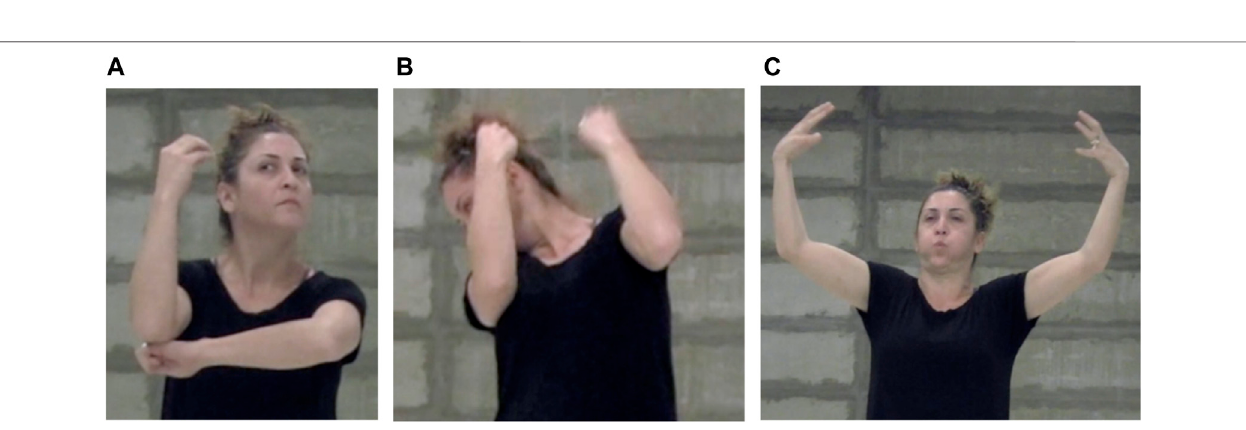
FIGURE 12 | (A) The sign LEARN with affective facial expression; (B) manipulation of the sign with a head gesture, meaning, “ learning more than can be taken in ” ; (C) gestures of hands and mouth indicating “ a huge amount ” near the head location, indicating “ too much knowledge. ”